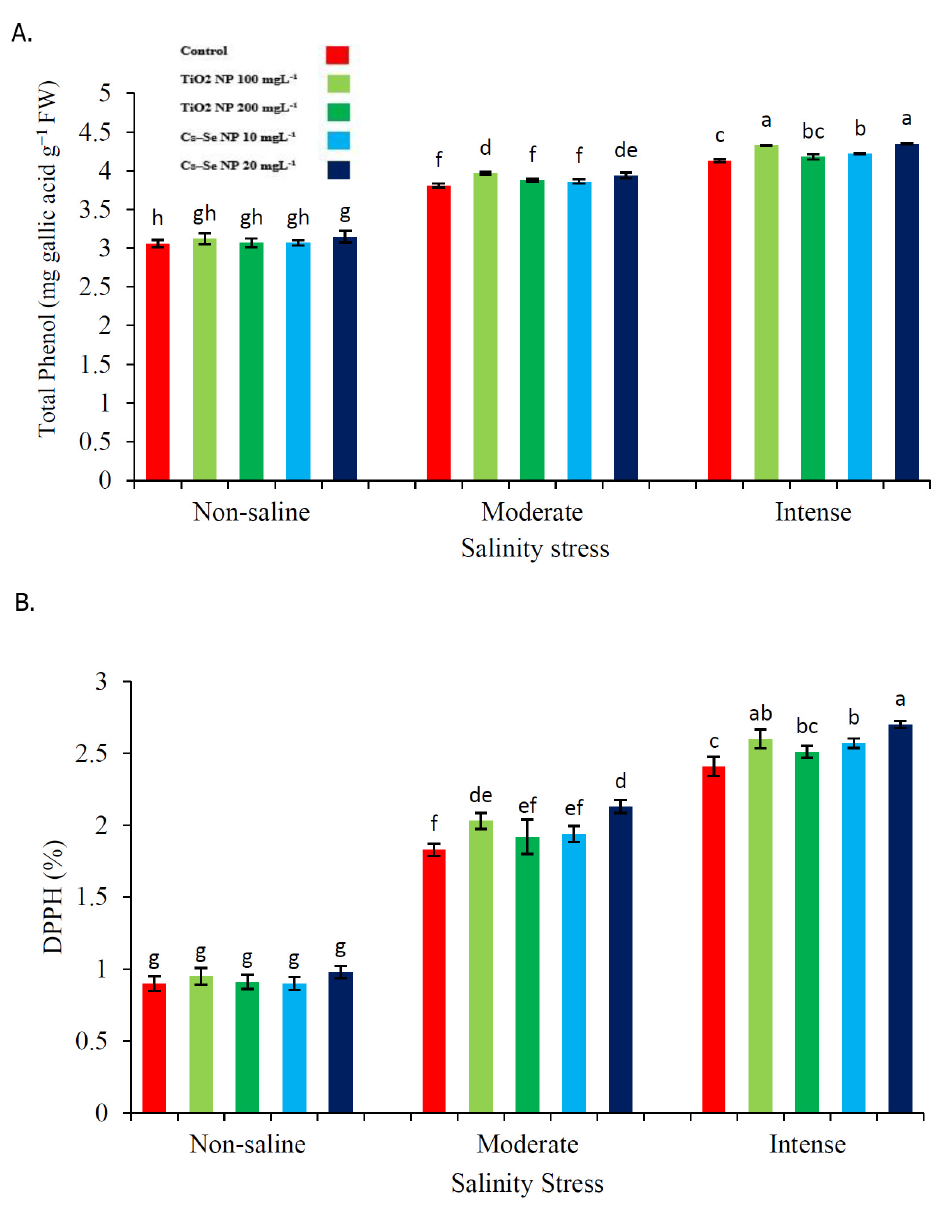
Figure 3. Effect of different concentrations of Cs–Se NPs and TiO 2 NPs on the Total Phenol ( A ) and total antioxidant capacity ( B ) of stevia ( Stevia rebaudiana Bertoni) leaves under salinity Stress. Data are the average of 3 repetitions ± standard error. Different letters indicate significantly different values according to Duncan’s post hoc analysis at p <